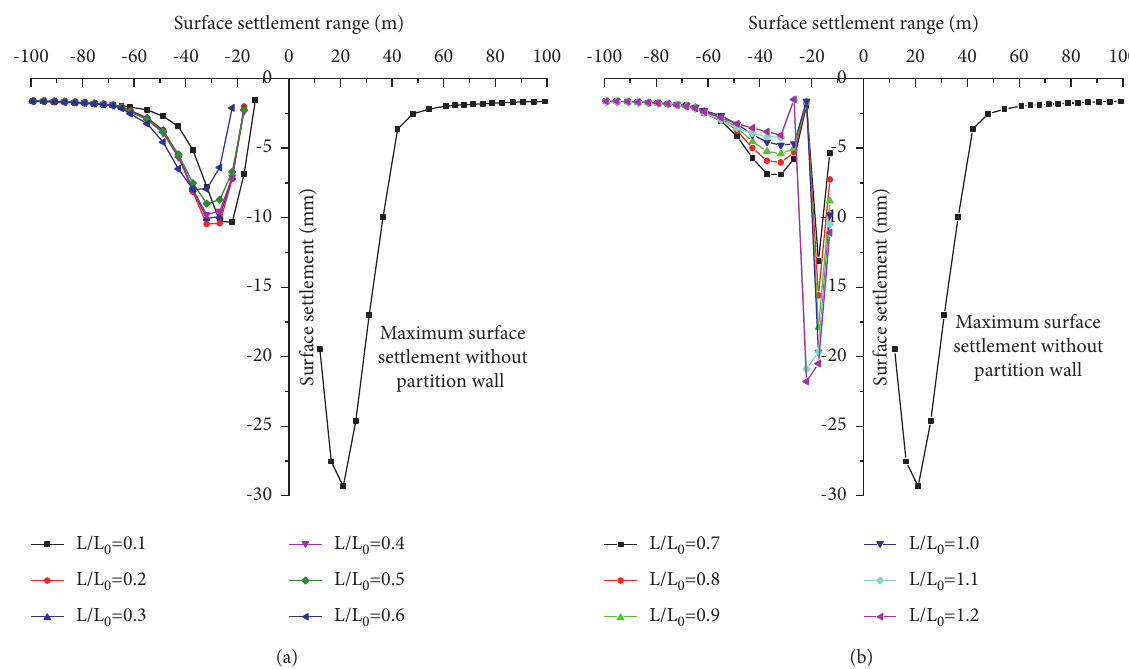
Figure 7: Affection of L / L